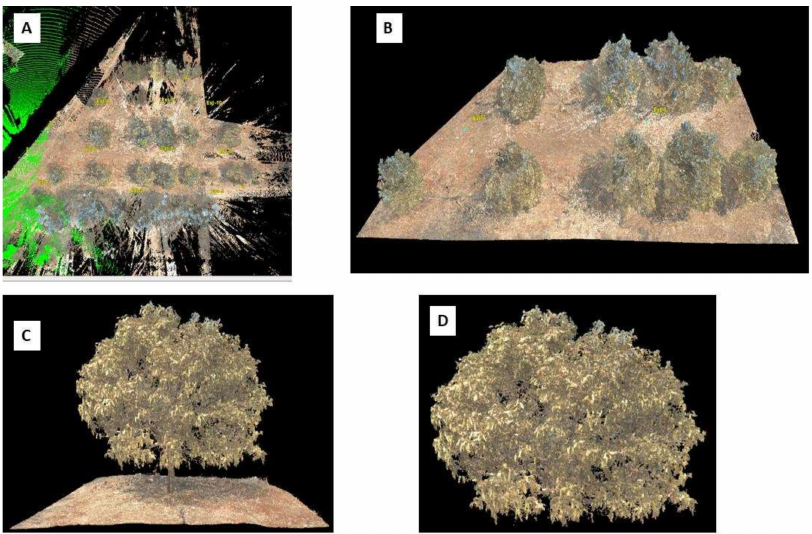
Figure 10. Model from HDS. ( A ) High-density point cloud. ( B ) Clipped point cloud. ( C ) Whole tree 2. ( D ) Tree crown